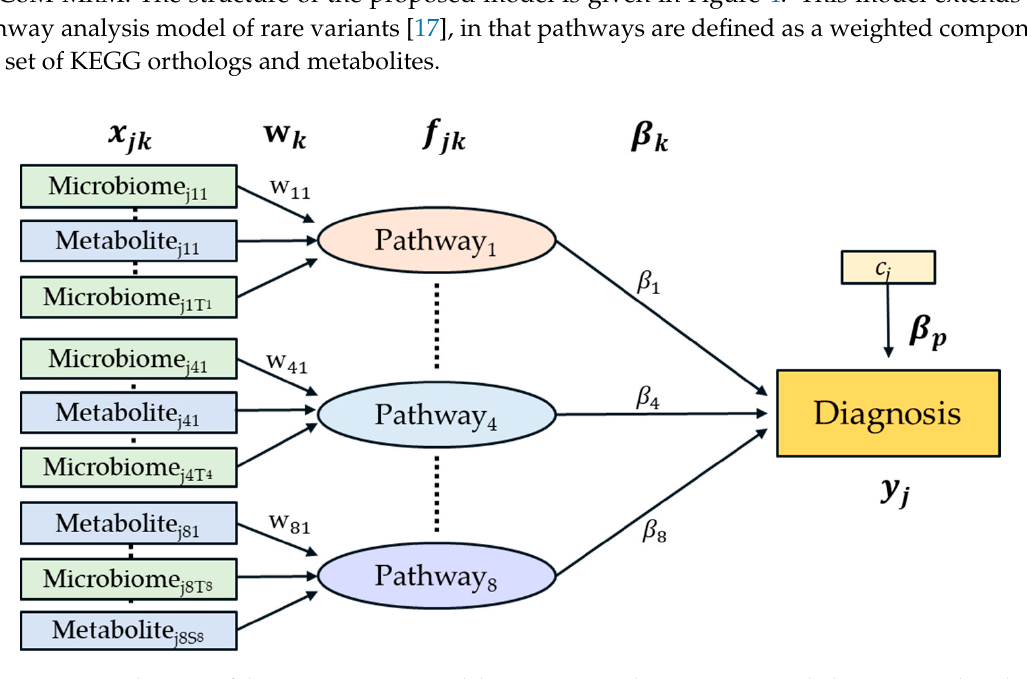
Figure 4. A diagram of the HisCoM-MnM model. Green rectangles represent metabolic genes predicted from microbiome data and blue rectangles represent metabolites. Each pathway consists of metabolic genes and metabolites.